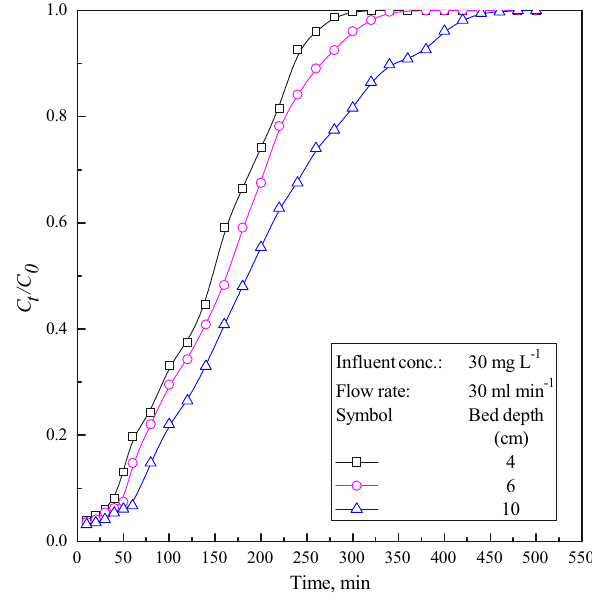
Fig. 4 Effect of bed depth for Cr(VI) ion adsorption